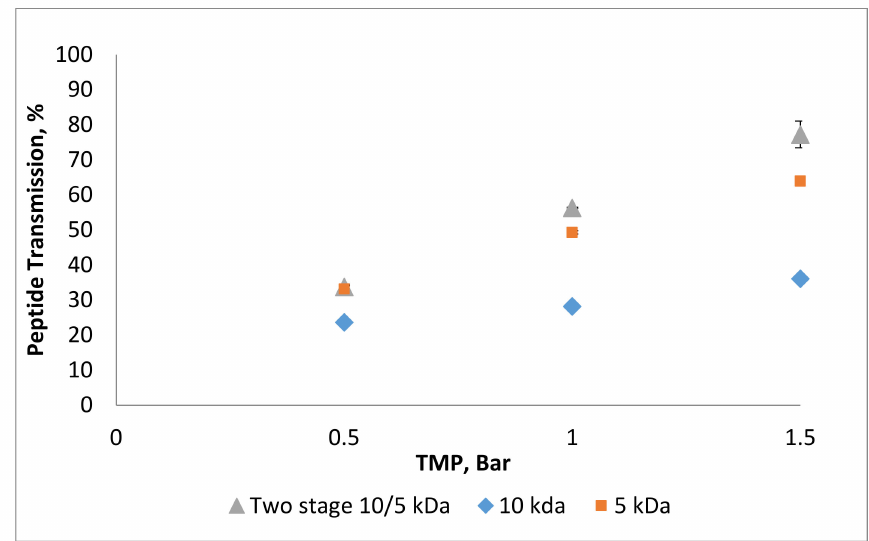
Figure 6. Peptide transmission at different trans-membrane pressure for single and two stage UF